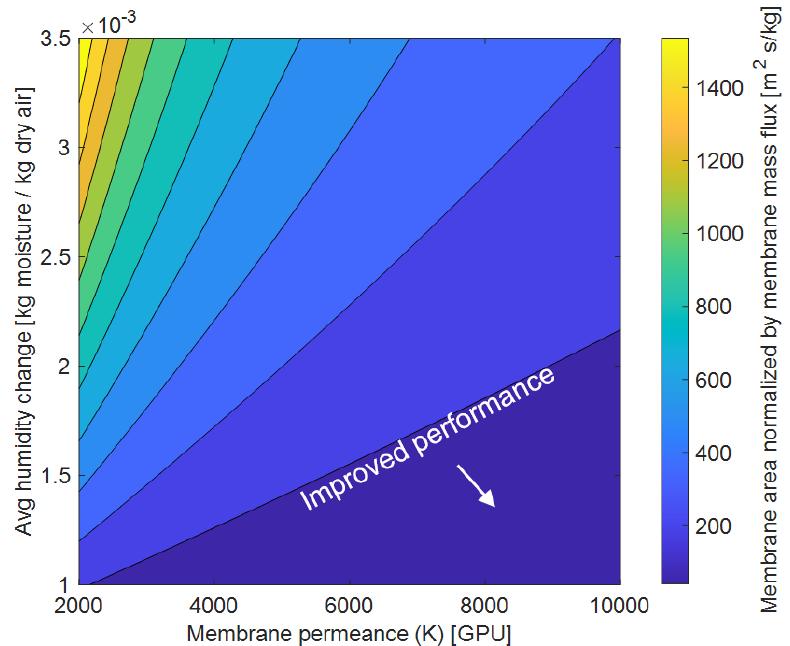
Figure 8. Impact of membrane permeance and humidity reduction on the normalize membrane area. Increasing permeance yields diminishing returns especially for smaller dehumidification needs (bottom right region). These conditions are T coil = 10 ◦ C, H = 0.006 m, N coils = 8, and h cs = 0.006 m.